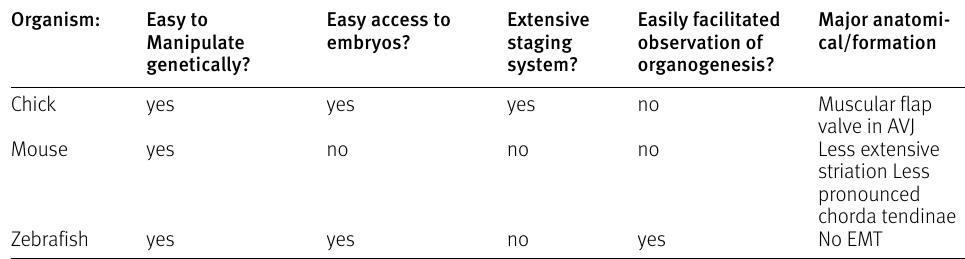
Table 4. Summary of advantages and disadvantages of animal models in the study of cardiac